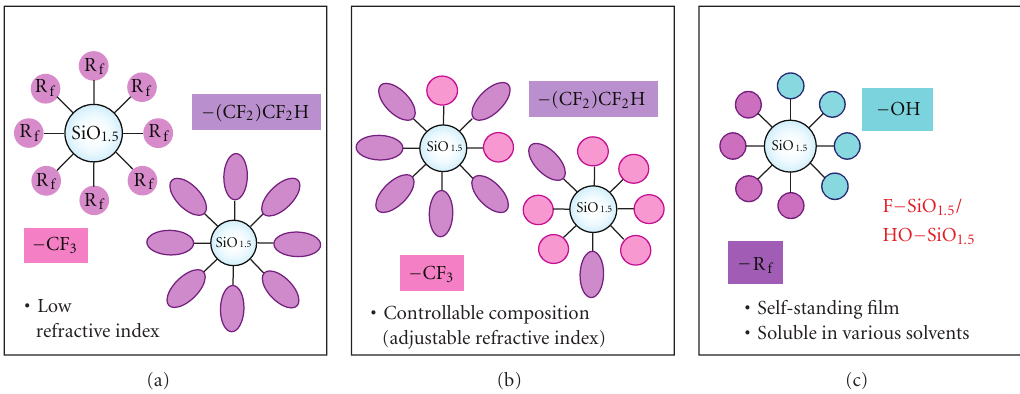
Figure 3: Summary of fluorinated silsesquioxane-based nanoparticles. (a) Fluorinated hybrids prepared by hydrolytic condensation of triethoxysilane precursors derived from fluoroalkyl acrylates; (b) cocondensation products obtained by hydrolytic cocondensation of TFEA-based and OFPA-based triethoxysilane precursors; (c) amphiphilic hybrids based on hydrolytic cocondensation of the hydroxyl- functionalized triethoxysilane precursor and fluorinated triethoxysilane precursors.